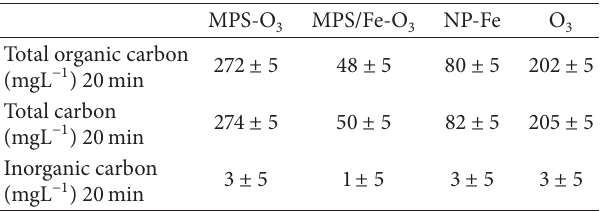
Figure 6: Effect of the tested materials on Isatin sulfonic acid concentration. Table 1: Effect of solid material on the final total organic carbon